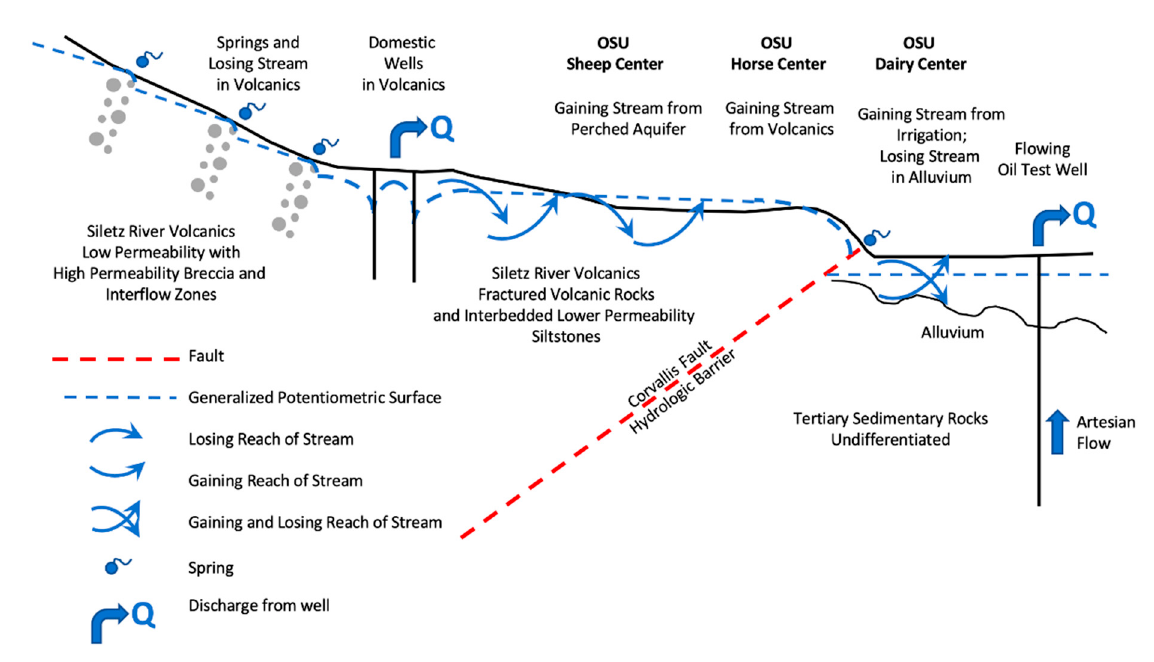
Figure 8. Summary sketch of hydrogeologic observations and interpretations. Not to scale. Generalized orientation of the section coincides with section A-A’ on Figure 1.